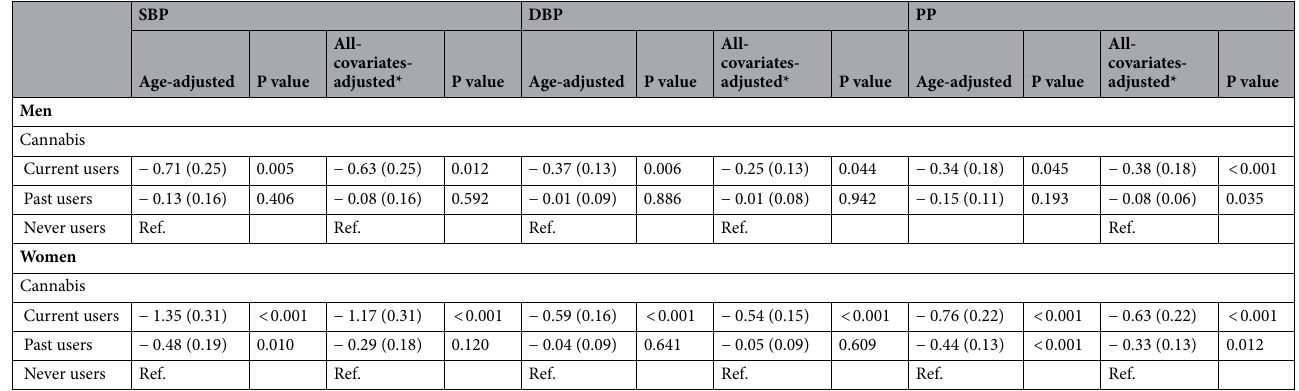
Table 5. Gender linear regression models for the relationship between current or past cannabis use and blood pressure (SBP, DBP and PP). SBP systolic blood pressure, DBP diastolic blood pressure, PP pulse pressure,